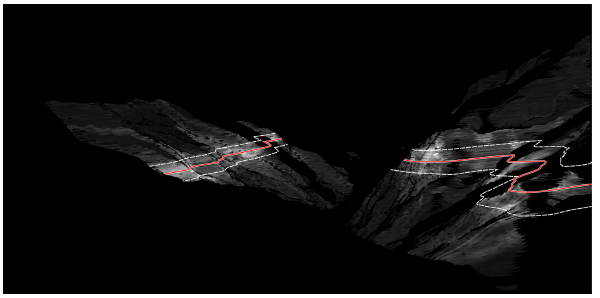
Figure 8. Standardized edge value for the scene from on 19 March 2013 from 10:12 to 10:16UTC + 8 (see also Fig. 4). The higher the edge value z , the brighter the shade. z CT slope is marked with the red line, while the interval of 1.2 times RMSD is the area between the dashed lines.